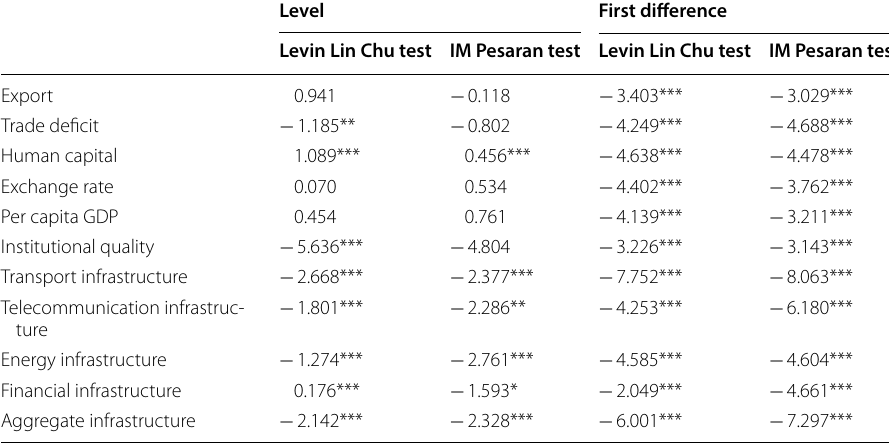
Table 2 Unit root test